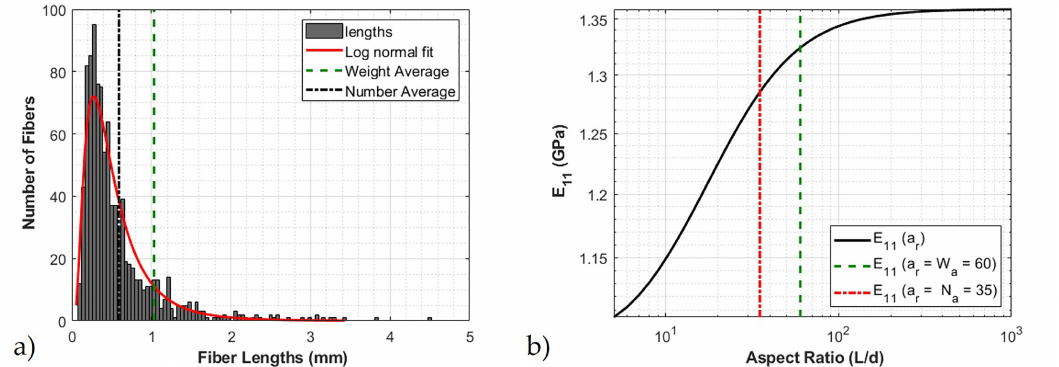
Figure 10. Glass fiber characteristics ( a ) Fiber length distribution ( b ) Effect of aspect ratio on the elastic